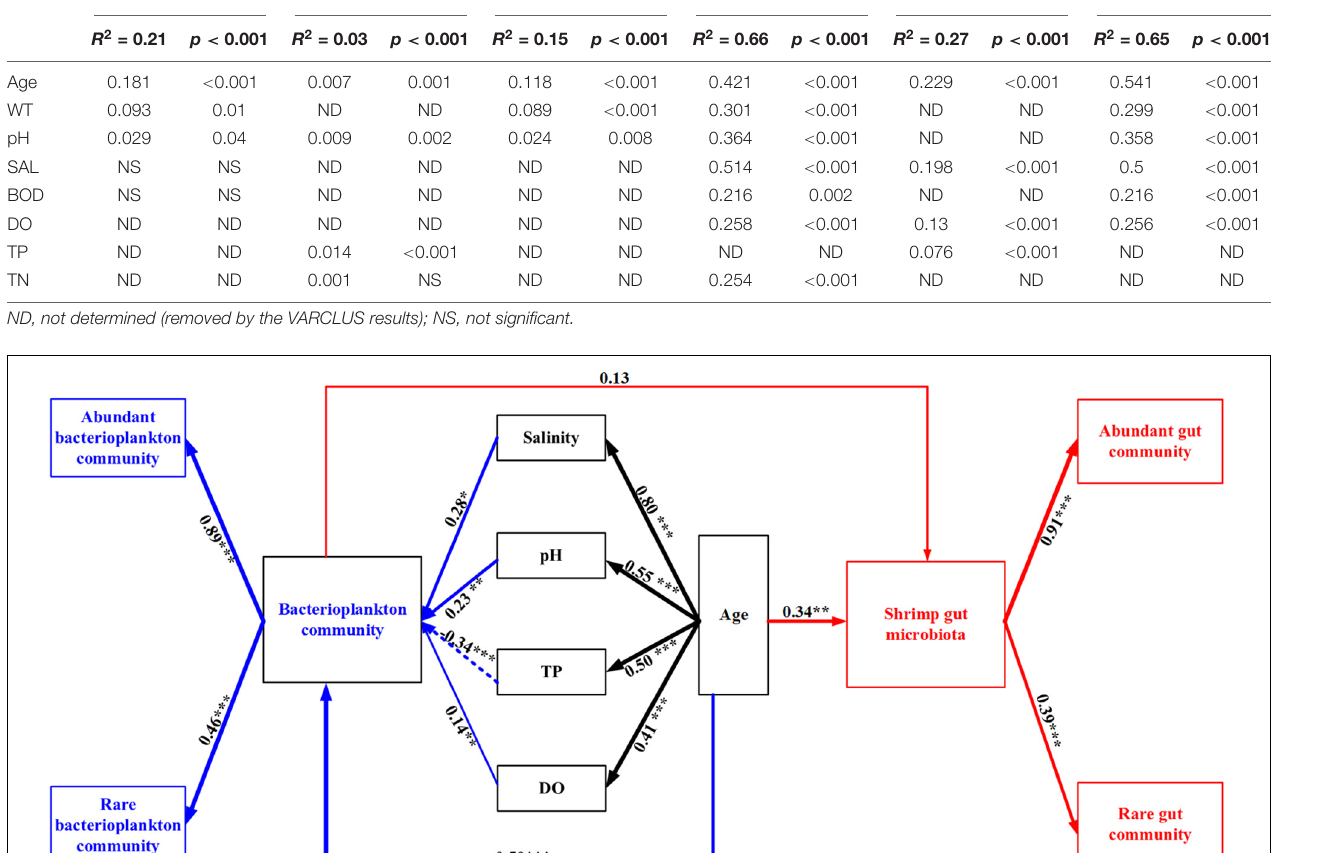
TABLE 2 | Results of the multiple regression on distance matrices (MRM) for shrimp gut, bacterioplankton, and their abundant and rare communities. Habitat Gut Rearing water Total Rare Abundant Total Rare Abundant